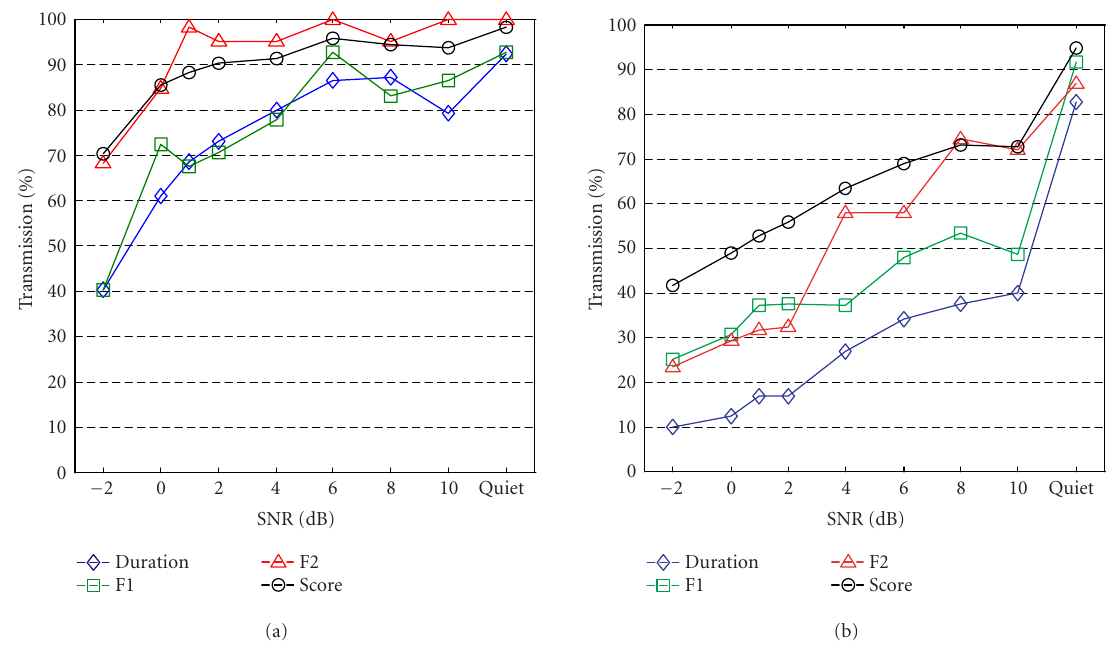
Figure 4: (a) 6/20F vowel information transmission analysis. (b) 8F vowel information transmission analysis.